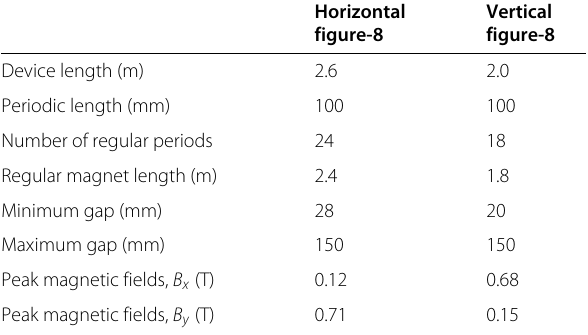
Table 4 ID parameters of horizontal and vertical figure-8 undulators comprising the SCU installed in SPring-8 BL07LSU